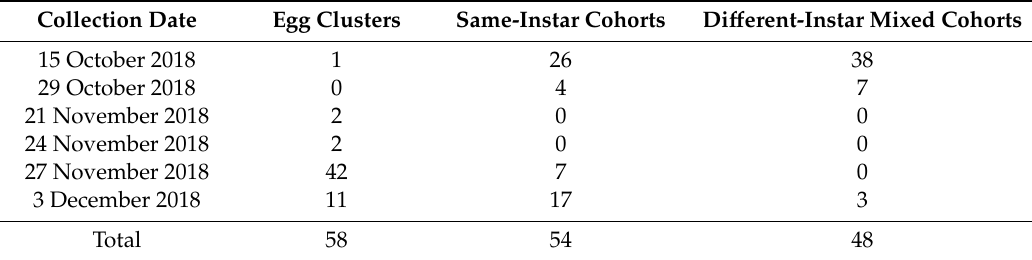
Table 1. Number of egg clusters and larval cohorts collected in each collection date. Egg